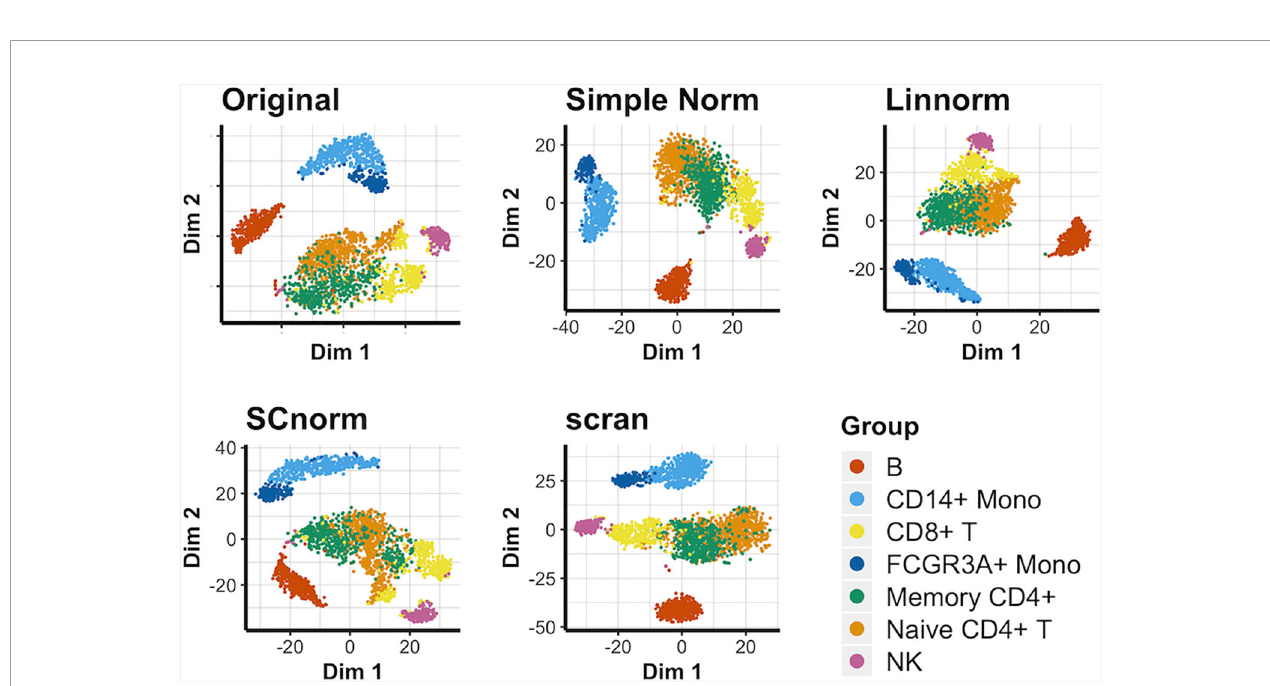
FIGURE 5 | t-SNE plots for the PBMC data under various normalization methods.